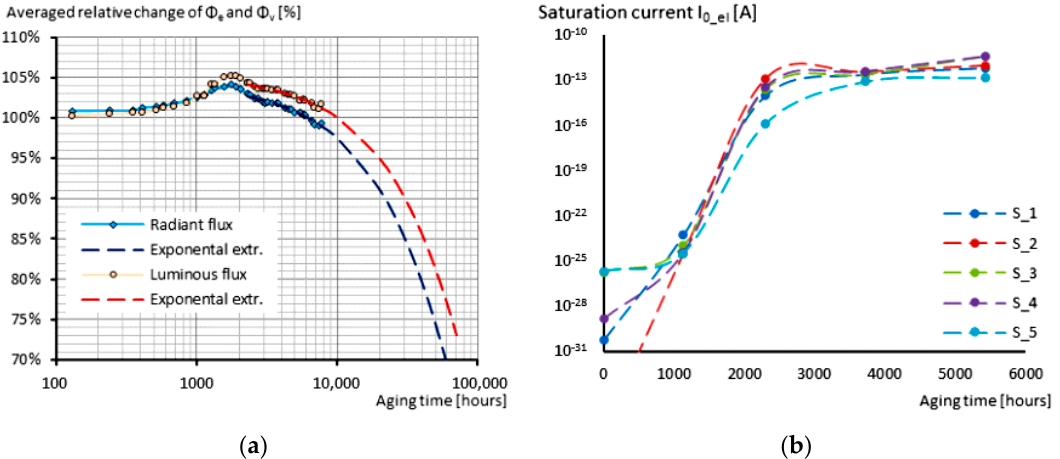
Figure 12. ( a ) Total luminous and radiant flux maintenance curves with their extrapolation [73]; ( b ) Time dependence of the model parameters: change of the saturation currents [73].